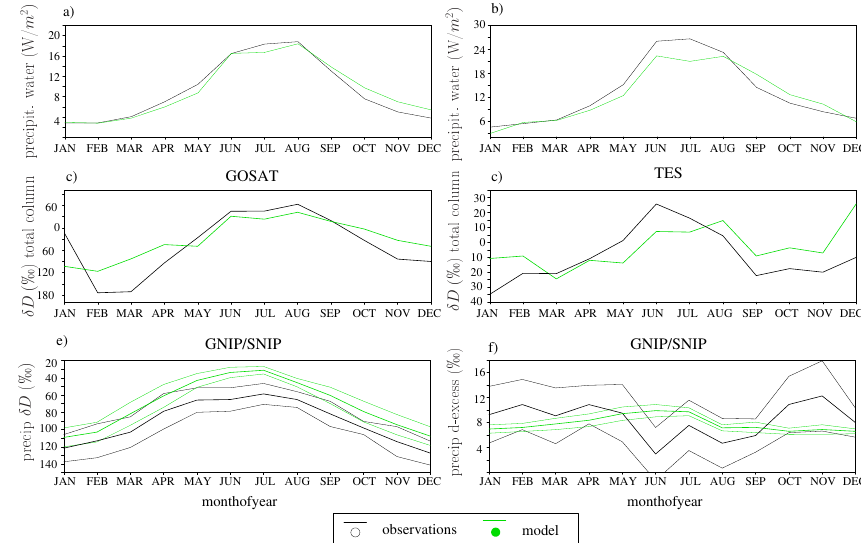
Figure 6. Seasonal cycles of observed (black) and simulated (green) precipitable water observed by GOSAT (a) and by TES (b), δD in the total column water vapor as observed by GOSAT (c) and by TES (d), δD (e) and d-excess (f) in the surface precipitation. We average over the region of Kourovka (50–64 ◦ N–50–70 ◦ E). For satellite data sets, the annual-mean δD is subtracted to focus on the seasonal variations. For GNIP/SNIP data sets, the spatial standard deviation is also plotted as an envelope. LMDZ outputs are collocated with each data set and averaging kernels are applied to compare with satellite data sets.